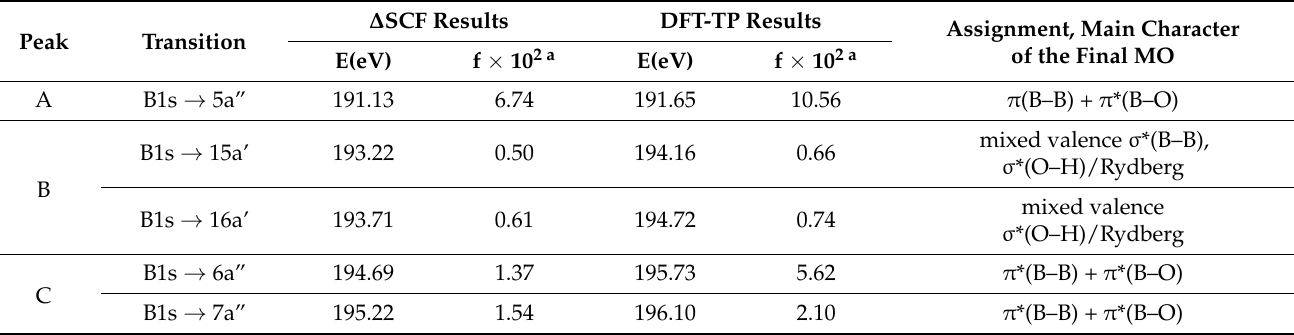
Table 1. Calculated B1s NEXAFS spectrum of THDB: ∆ SCF and DFT-TP transition energies (in eV) and oscillator strengths (f × 10 2